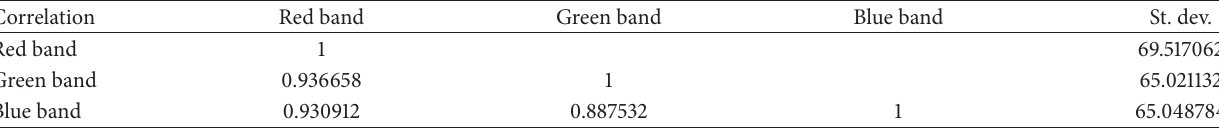
Table 2: Aerial imagery RGB triband relevance